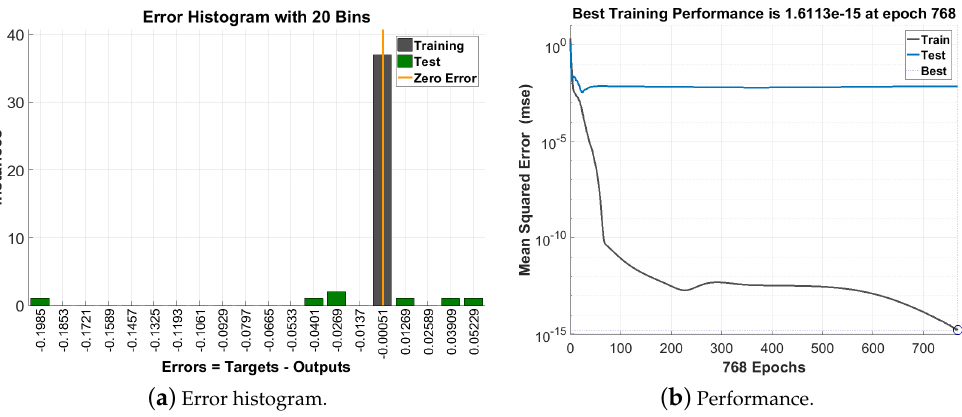
Figure 12. NARX error histogram and